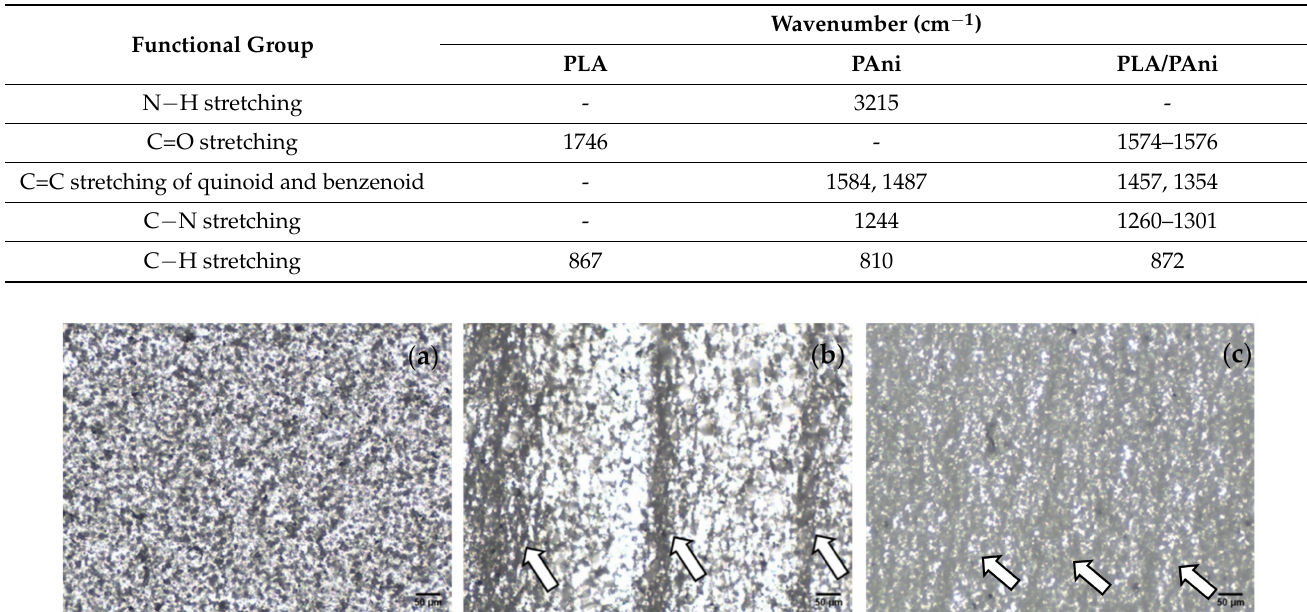
Figure 2. FTIR spectra of pristine PLA, pristine PAni, and PLA/PAni film. Table 2. Functional group for pristine PLA, pristine PAni, and PLA/PAni film.